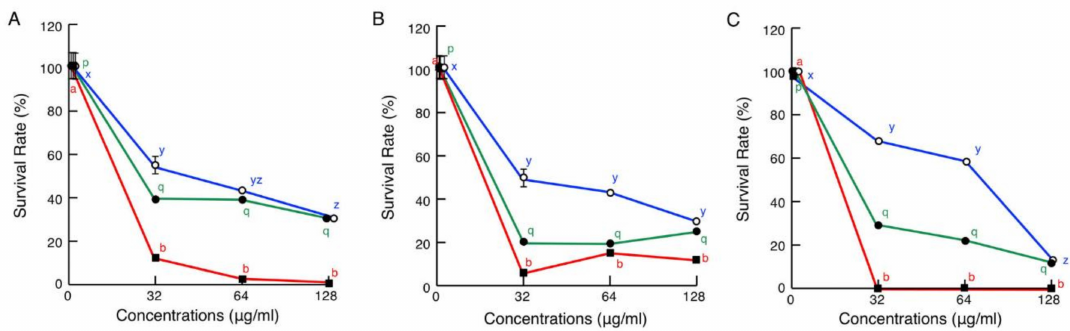
Figure 8. Cytotoxic e ff ects of brevinin-2SSb (red lines), ranatuerin-2SSa (green lines), and granuliberin-SSa (blue lines) in eukaryotic cells. Media containing 5 × 10 3 COS7 ( A ), HepG2 ( B ), or CPAE ( C ) cells in 500 µ L aliquots were incubated with brevinin-2SSb, ranatuerin-2SSa, or granuliberin-SSa at 0, 32, 64, and 128 µ g / mL for 24 h at 37 ◦ C, and cell proliferation was determined using standard MTT assay. Cell survival rates were calculated from MTT reduction values and are expressed relative to control (0 dose) cell viability. Points and vertical bars represent means and SEM, respectively ( n = 4). In all panels, values with the same letters are not significantly di ff erent ( p ≥